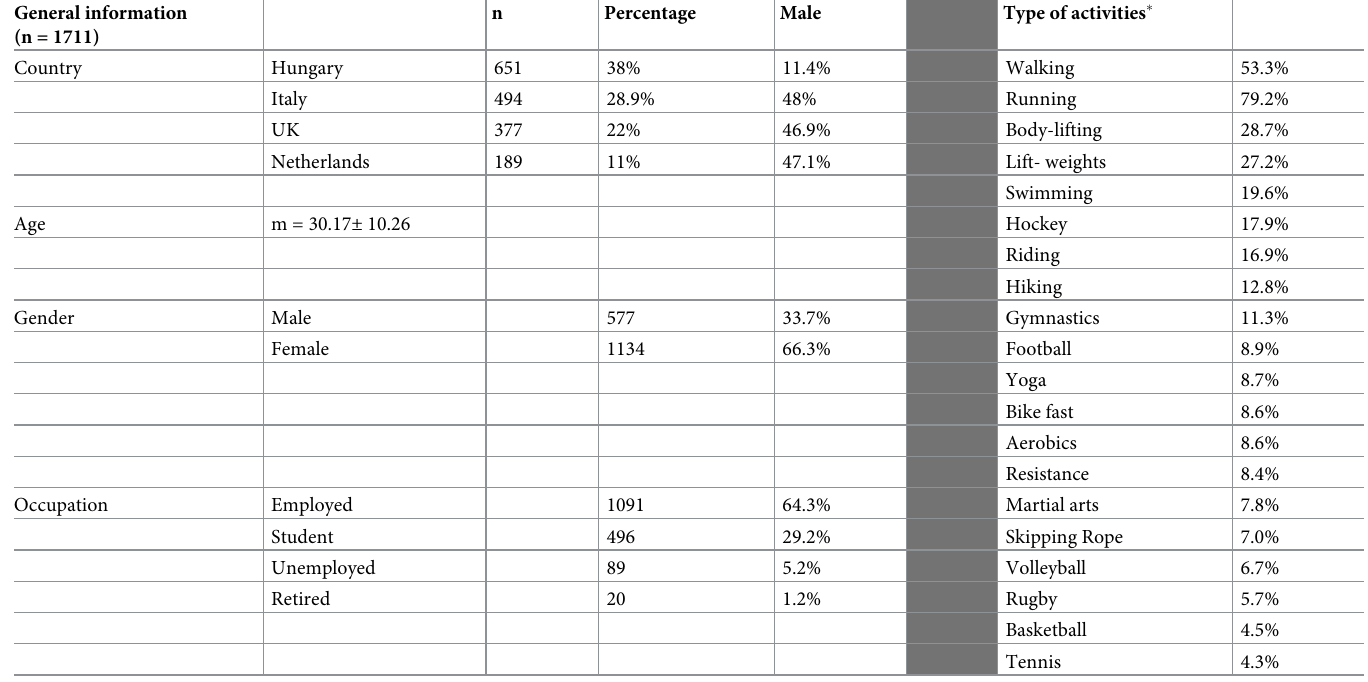
Table 1. Sample description (N = 1711) with specification of demographics and types of physical activities. General information (n = 1711)